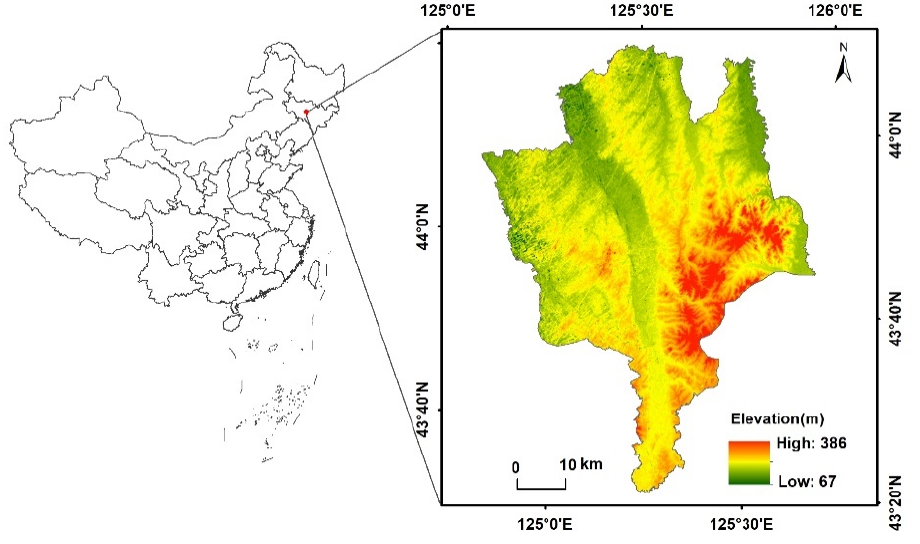
Figure 1. Location of the Changchun, Jilin Province, China.